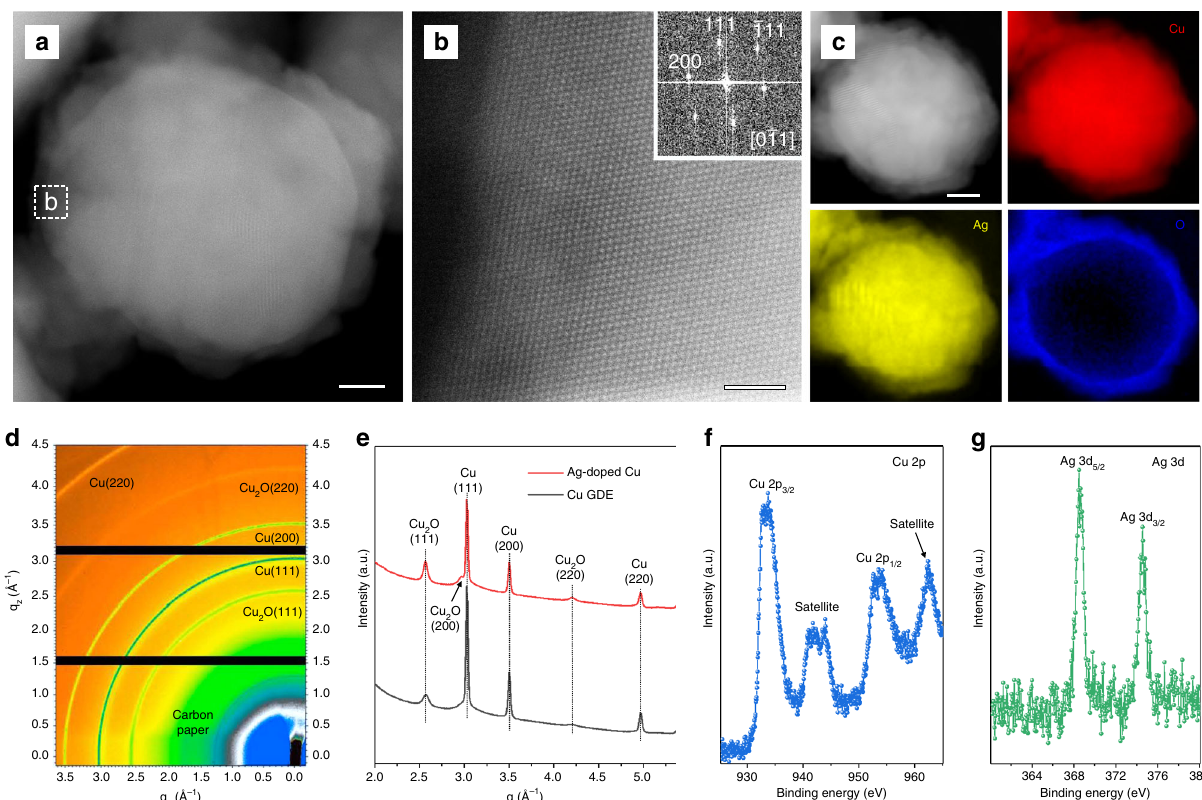
Fig. 2 Structural and compositional analyses of Ag-doped Cu catalyst. a High-angle annular dark- fi eld scanning transmission electron microscopy (HAADF- STEM) image taken from a single particle. Scale bar, 20 nm. b Atomic-resolution HAADF-STEM image taken from the edge of a nanoparticle marked by a box in ( a ). Inset, the corresponding Fourier transfer image. Scale bar, 2 nm. c HAADF-STEM image of an Ag-doped Cu nanoparticle and the corresponding EELS elemental mappings of Cu, Ag, and O. Scale bar, 20 nm. d , e WAXS map ( d ) and the corresponding sector-average of WAXS map ( e ) for Ag-doped Cu GDE. f , g High-resolution Cu 2p ( f ) and Ag 3d ( g ) spectra of Ag-doped Cu